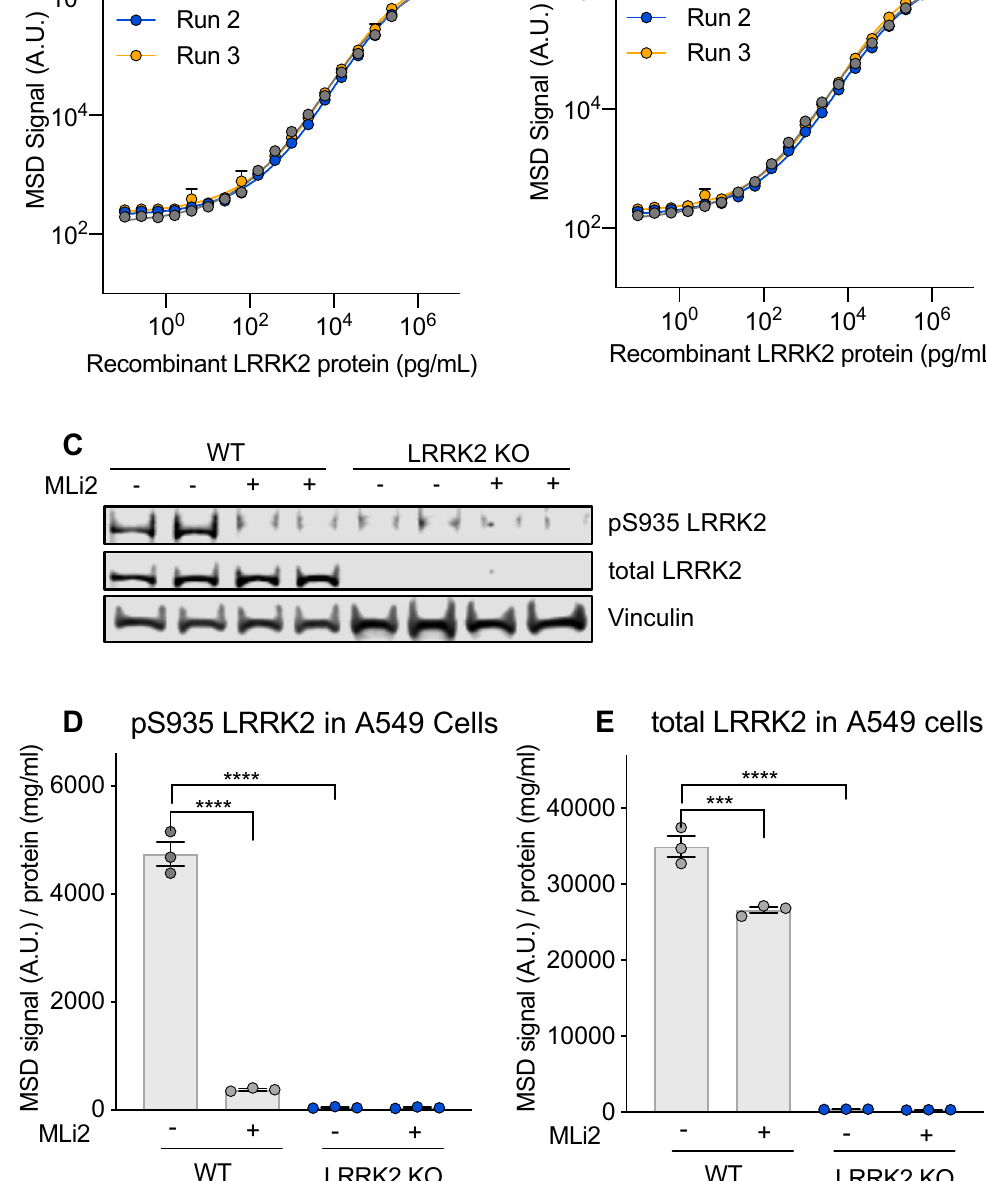
Figure 1. Development of specific, quantitative and high-throughput assays to measure pS935 LRRK2 and total LRRK2. ( A , B ) Novel MSD assays to measure pS935 LRRK2 and total LRRK2 levels can detect increasing amounts of recombinant LRRK2 protein; n = 3. ( C ) Specific detection of pS935 LRRK2 and total LRRK2 was confirmed in WT and LRRK2 KO A549 cells with and without LRRK2 kinase inhibitor treatment (MLi-2, 500 nM, 2 h) measured by western blot analysis. ( D , E ) Consistent with western blot data, the LRRK2 MSD assays specifically detected pS935 LRRK2 and total LRRK2 in A549 cells; n = 3. MSD signals were normalized for protein concentration, and data are shown as mean ± SEM with p values: one-way ANOVA with Tukey’s multiple comparison test; ***p ≤ 0.001, ****p ≤ 0.0001; AU, arbitrary